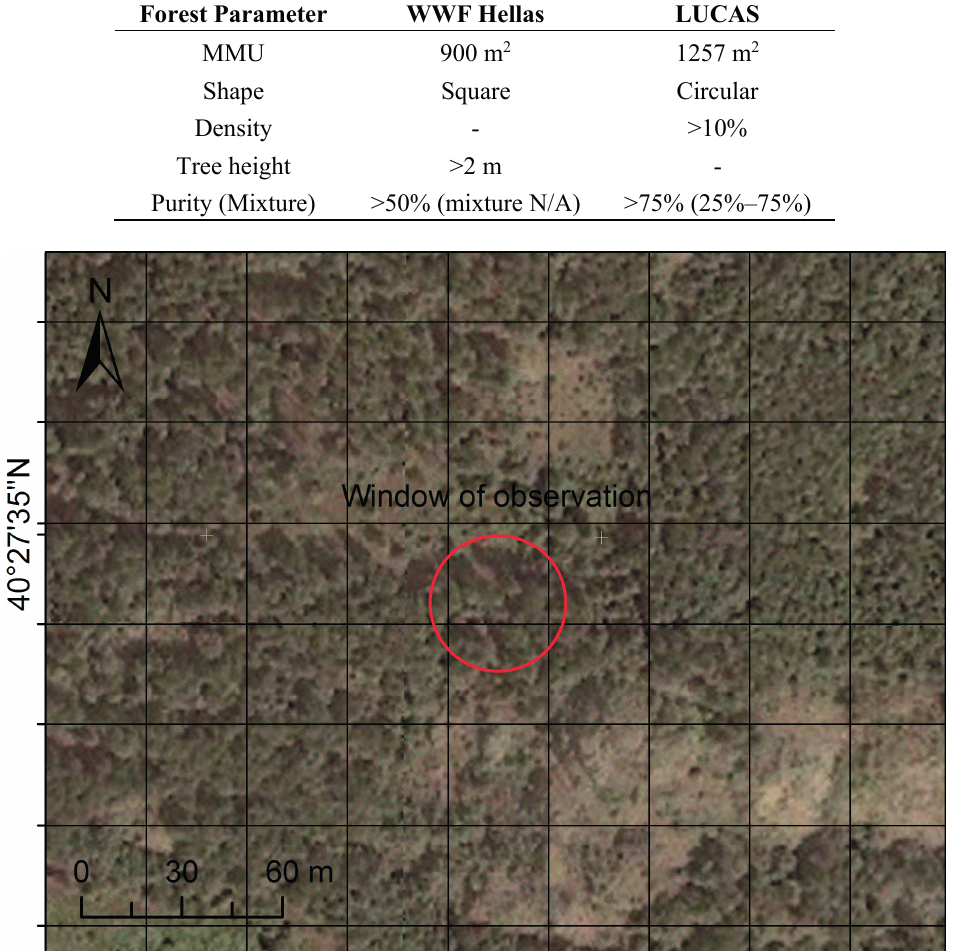
Table 2. Comparative list of terms used for the definition of forestland cover according to the WWF Hellas map and LUCAS nomenclature.